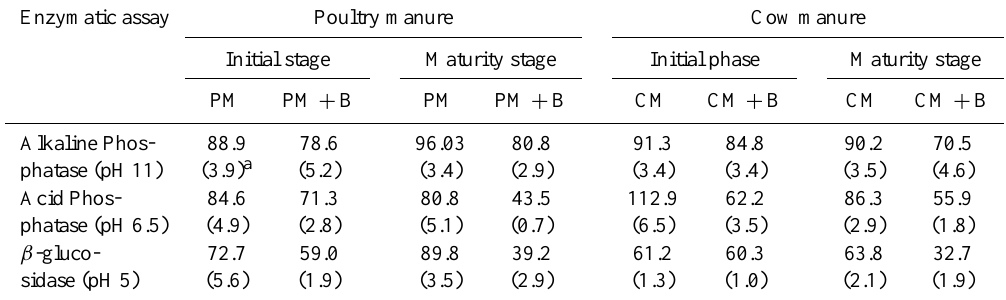
Table 3. Percentage of PNP recovery calculated by the linear fitting of the measured amount of PNP (PNP exp ) and the amount of PNP added (PNP add ), according to the equation PNP exp = k × PNP add . The percentage of PNP recovery is expressed as 100 · k . Poultry manure compost (PM), poultry manure blended with biochar (PM + B), cow manure (CM), and cow manure blended with biochar (CM + B). Enzymatic assay Poultry